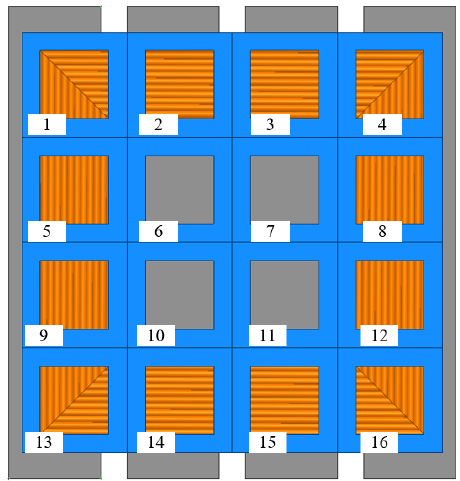
Figure 5. Symmetrically shaped detector coil array and WPT system coil. Table 4. System parameters.